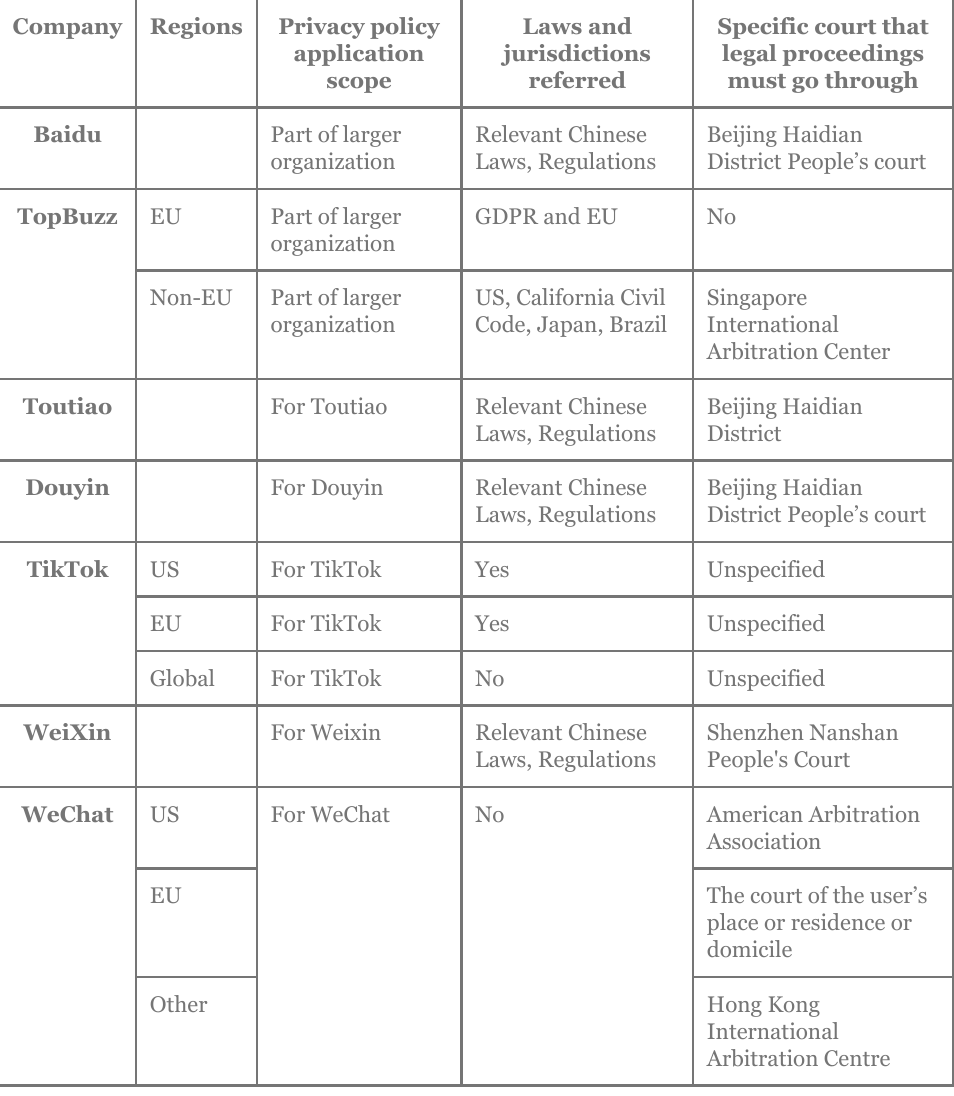
Table 1: Cross-border